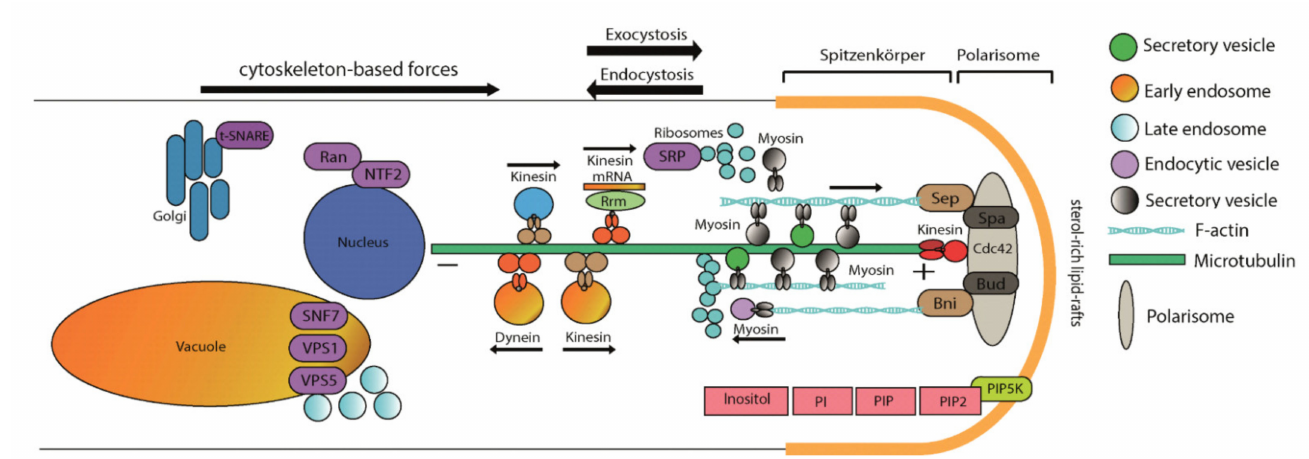
Figure 7. Model integrating inositol signaling in intracellular and membrane trafficking. Supplementary Materials: The following are available online at https://www.mdpi.com/article/10 Table S2: Primers used in this study, Supplementary Figure S1: Plasmid construction for generation of imp1 overexpression strains, Supplementary Figure S2: Verification of imp1 overexpression by RT-qPCR, Supplementary Figure S3: Effect of imp1 overexpression on colony morphology (top) and growth (below) of S. commune , Supplementary Figure S4: Susceptibility towards calcofluor white (A), SDS (B), and Congo red (C), Supplementary Table S3: Regulation of genes involved in the inositol signaling cycle, Supplementary Table S4: Intracellular trafficking associated proteins regulated in imp1 overexpressing transformant pOEIMP4 vs. EVC, Supplementary Figure S5: Chromosomal map of imp1 surrounding genes in three different strains S. commune , H4-8, LoeD, and